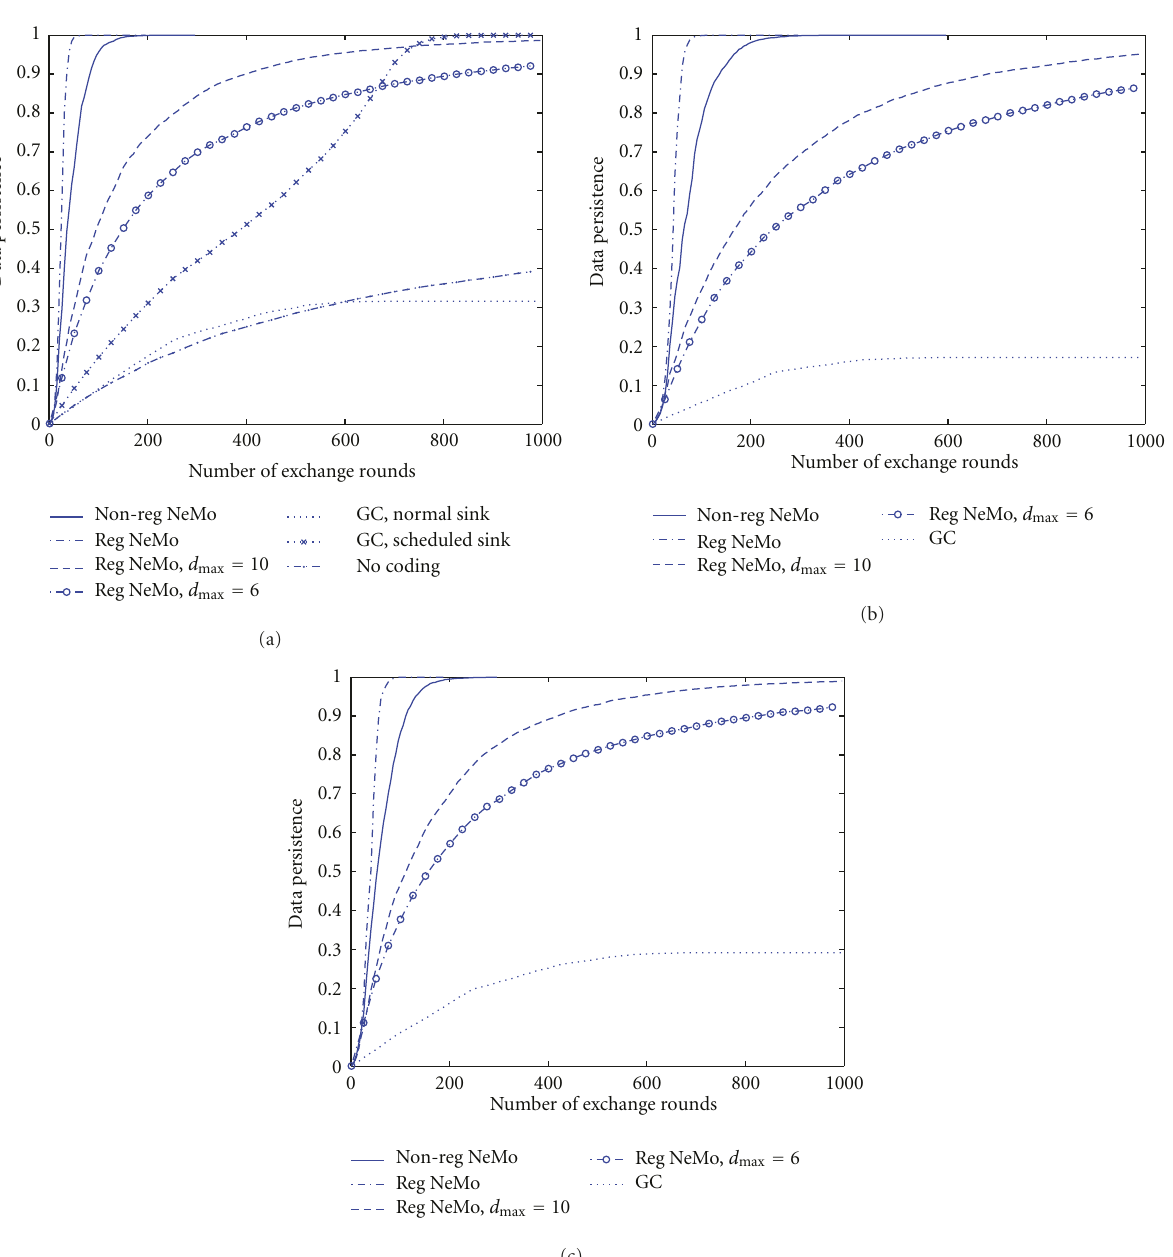
d M d e + ( d − d e × e ) operations are needed to demodulate one NM symbol at the sink. The demodulation complexity at the sink for di ff erent d max when BPSK is employed is plotted in Figure 7(b). As d max becomes large, the sink receives NM symbols with higher degree and hence the complexity becomes higher due to exhaustive search for